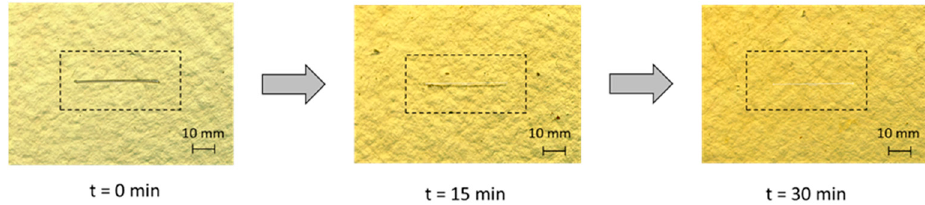
Figure 10. Optical microscope images of the thermal self-healing process at 190 ◦ C at different times for sample SQLM 2575 BASE.